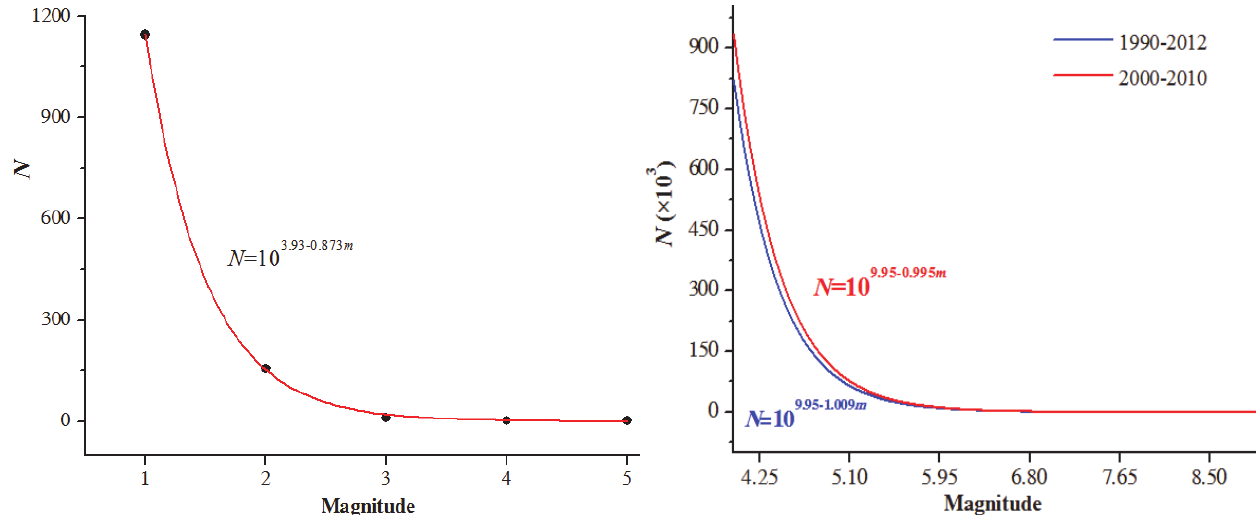
Figure 11: AE magnitude distribution curve. Figure 12: Magnitude frequency distribution of the